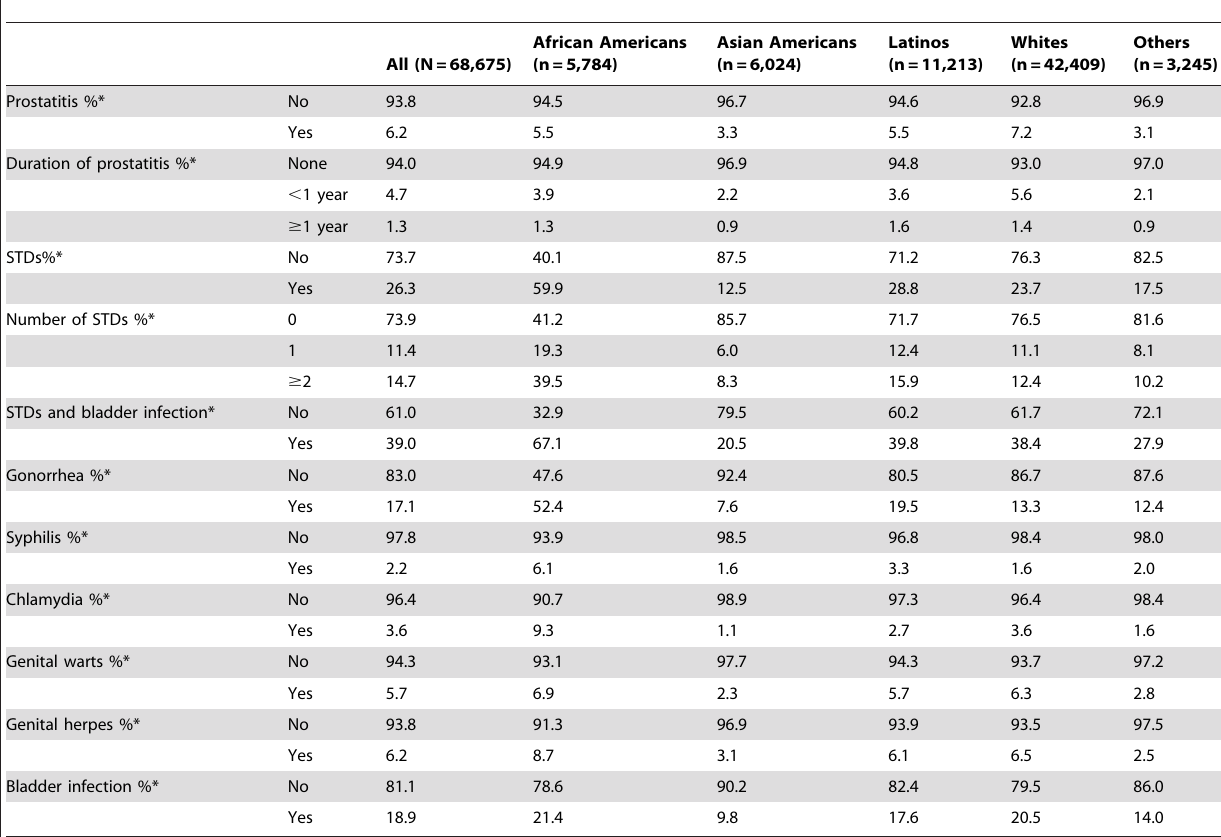
Table 2. Distribution of prostatitis and STDs among all men and by racial/ethnic group, California Men’s Health Study, 2002–2006.